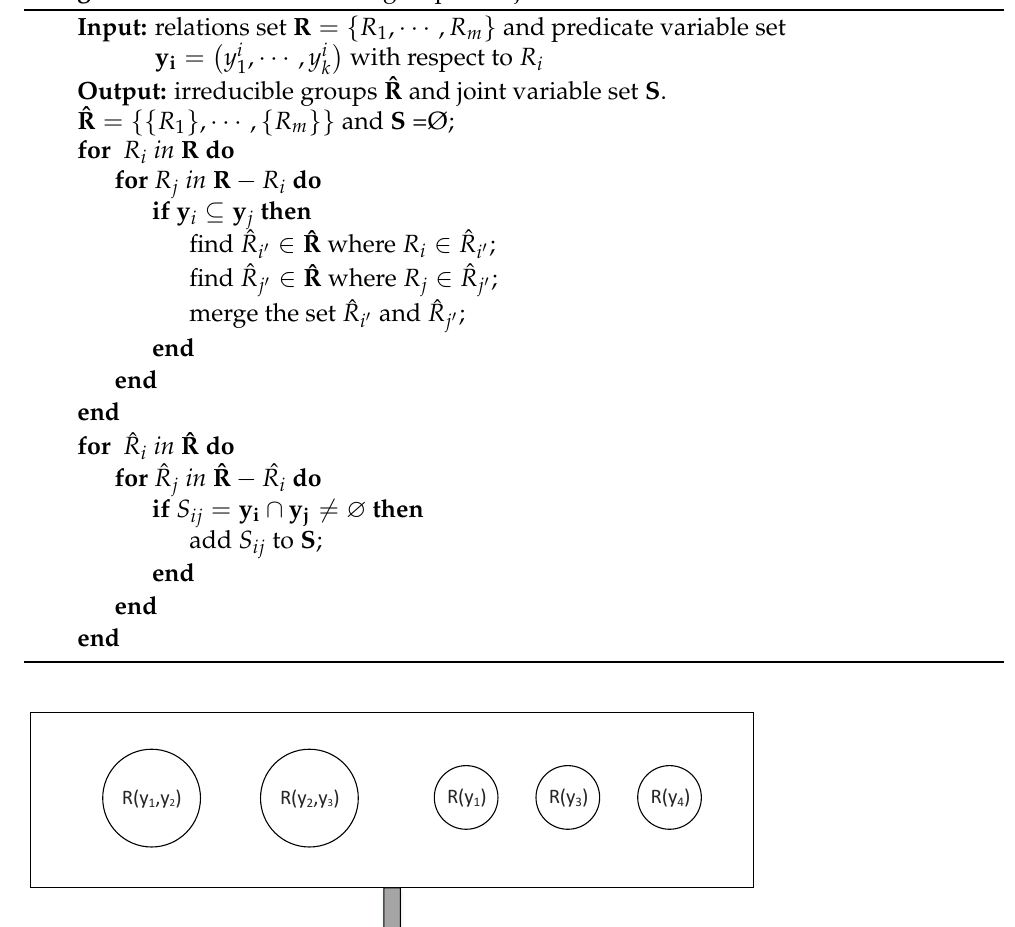
Algorithm 1: Find irreducible groups and joint variables.